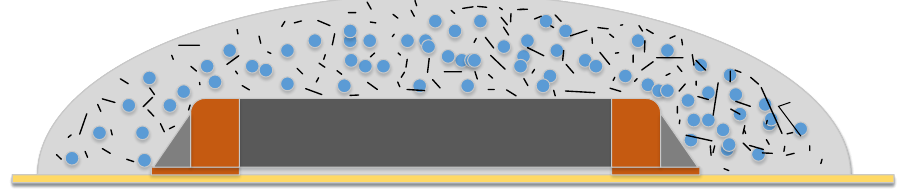
Figure 6. Example of a resin fixation matrix (light grey) with additives (black strings) and the PCM (blue) on top of a chip resistor (orange/dark grey), soldered on a PCB